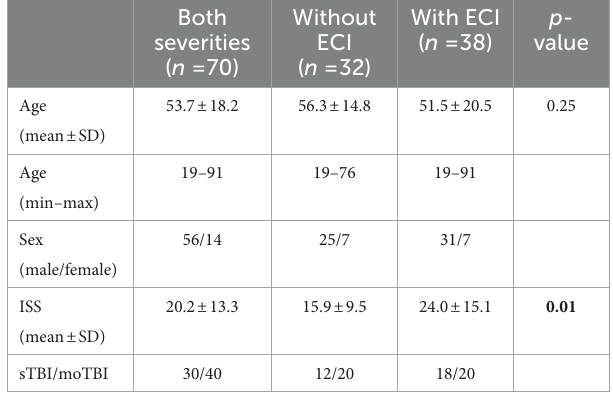
There were 82 patients with mo/sTBI, but 12 patients lacked blood samples, leaving 70 patients with available biomarkers. There were 56 males (80%) and 14 females (20%), with a mean age of 53.7 ± 18.2 years. There were 32 patients (46%) without ECI and 38 patients (54%) with ECI. There were 30 patients with sTBI (43%) and 40 patients with moTBI (57%) in the study cohort. Demographic data are presented in Table 1.